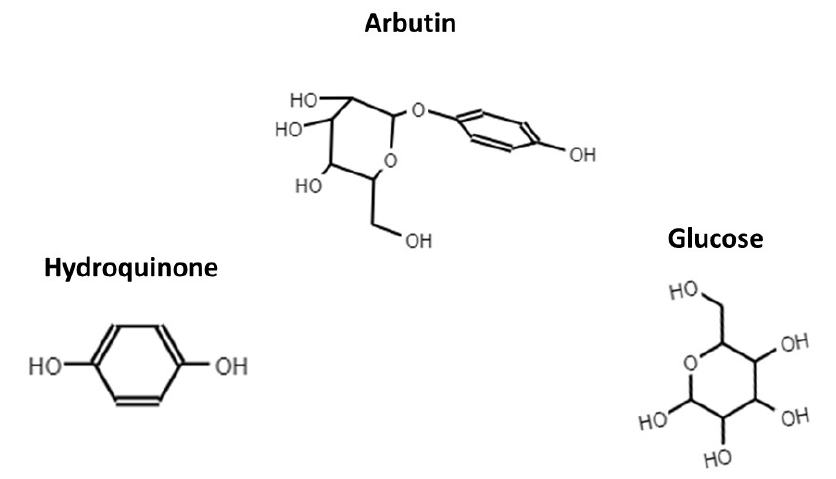
Figure 1. Chemical structure of arbutin, hydoquinone and